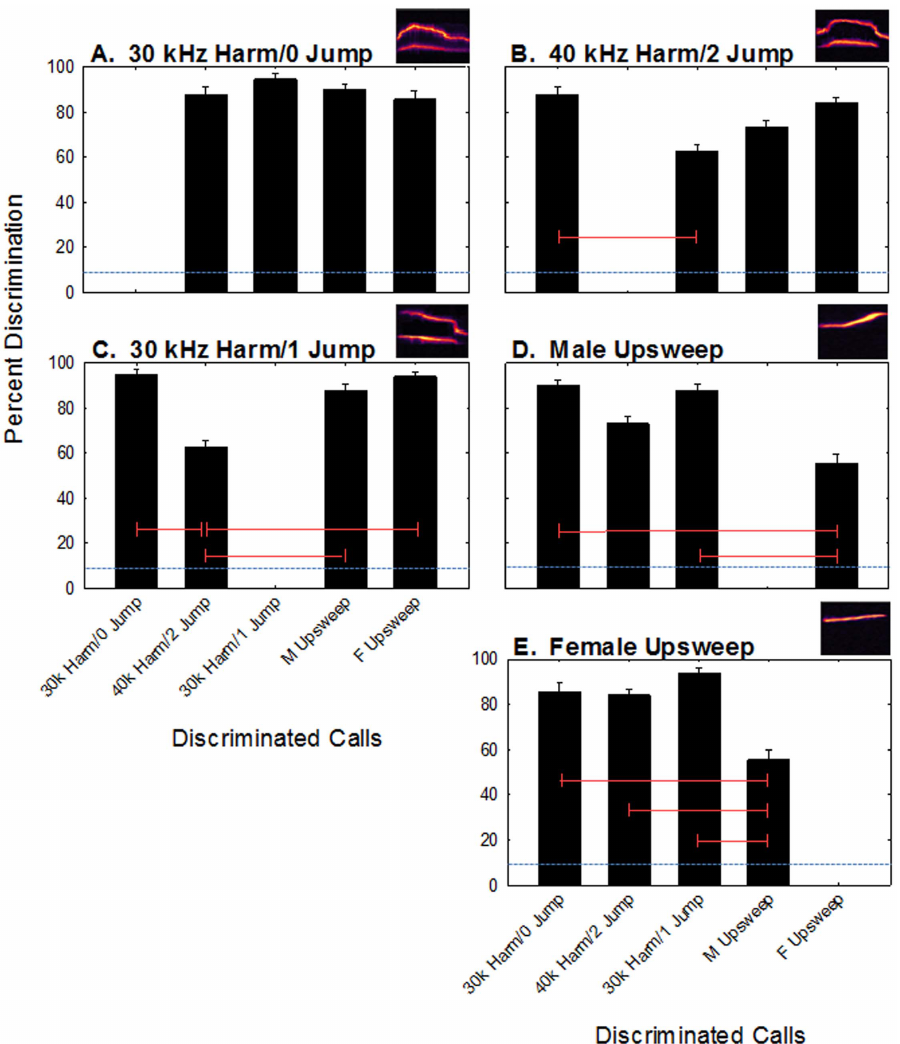
Figure 2. Discrimination of vocalizations. Mean discrimination performance across subjects for the five vocalizations types (A-E) against all other vocalizations. The blue horizontal dashed lines represent chance level performance. Error bars are between-subject standard errors. The red horizontal lines connect significantly different bars. The missing bar in each of the graphs is when the stimulus was used as the background.